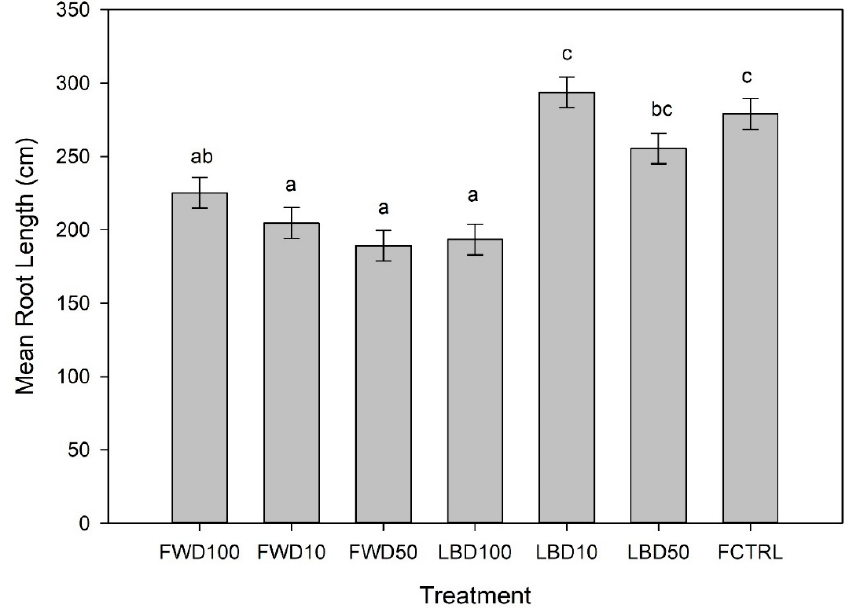
Figure 4. Treatment effects on least squared means (Lsmeans) for root length averaged over all time points. Error bars are the standard error of the mean ( n = 5), and means that do not share a letter are significantly different ( p < 0.05).